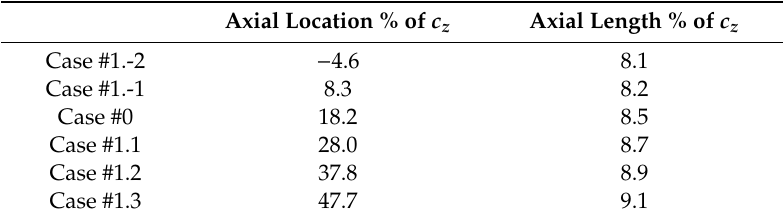
Table 3. Parametric study of the recirculation channel location on the rotor shroud wall.